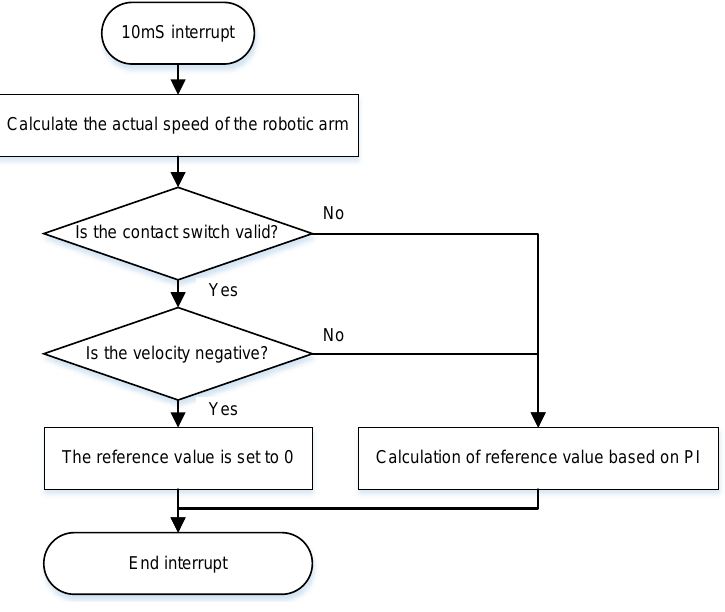
Figure 16. The 10 mS timer interrupt flow chart.